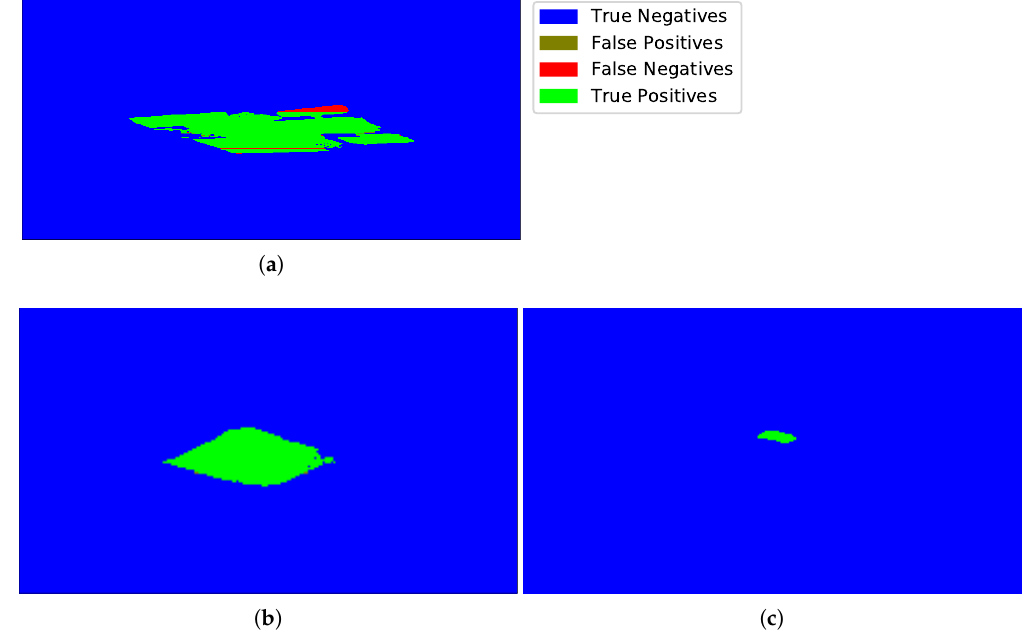
Figure 11. Three captions of the simulation run with results shown in Table 2, with parameter d set to 5. ( a ) Tractor detection results; ( b ) rock detection results; ( c ) person detection